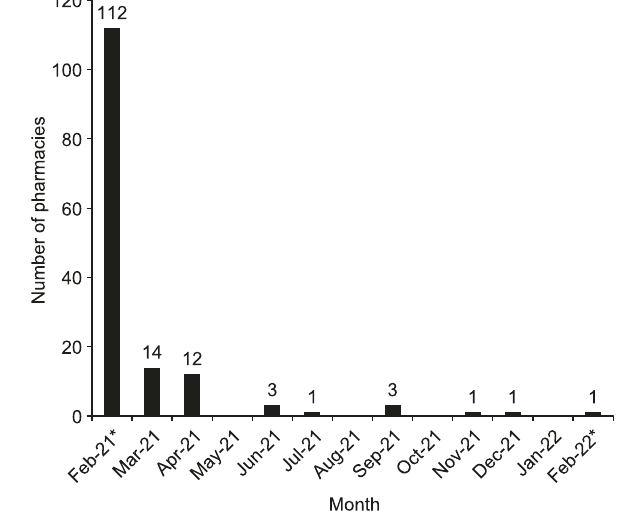
Fig. 2 Number of pharmacies enrolled in Take AIR in each month. *February 2021 and February 2022 data include only 2 weeks of the